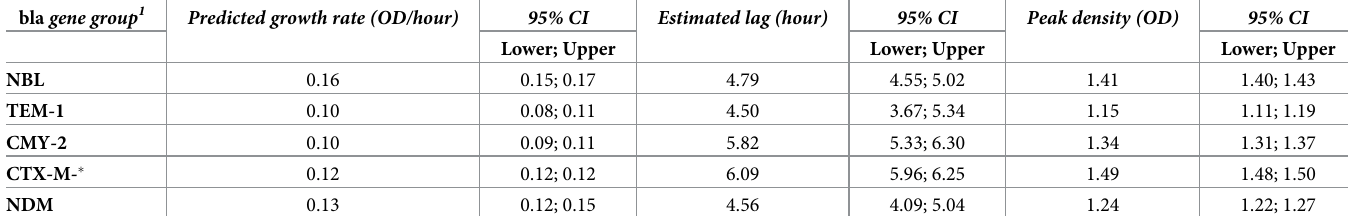
CI: 0.135–0.155] for the CPE group (see Table 2 and Fig 3). Correspondingly, the CPE group and the ESBL producers both demonstrated comparable robust growth in 4 μ g/mL ceftriaxone and in plain CAMH-2 broth [0.127 (OD/hour), 95% CI: 0.121–0.132] compared to [0.133 (OD/hour), 95% CI: 0.122–0.144] for ESBL producers; and [0.142 (OD/hour), 95% CI: 0.136–0.149] compared to [0.135 (OD/hour), 95% CI: 0.128–0.142] for the CPE group; however, AmpC producers (i.e., harboring only bla Table 3. Bacterial growth parameter values with 95% confidence intervals estimated by a 3-parameter Gompertz model, for strain pairs used in the batch competi- tion assay. bla gene group 1 Predicted growth rate